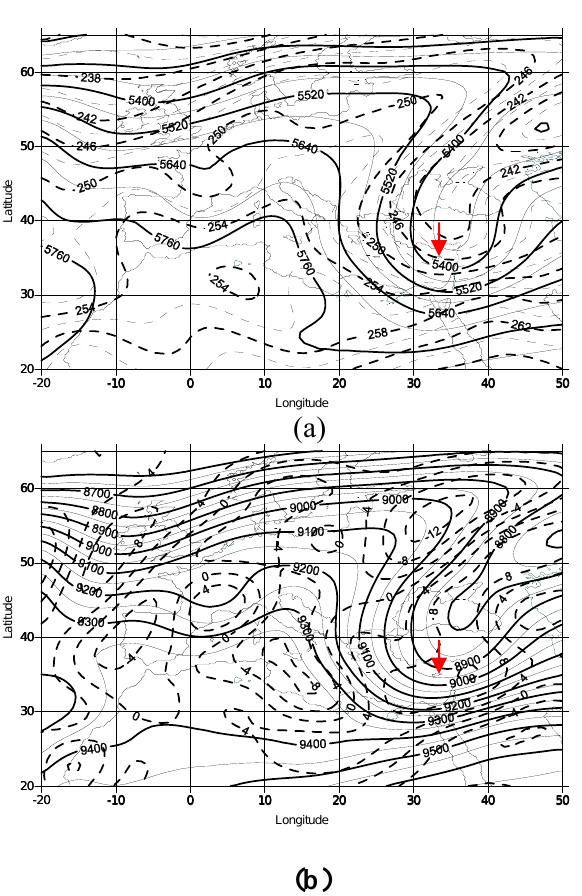
Fig. 11. As Fig. 4, but for 0000 UTC 30 January2008.